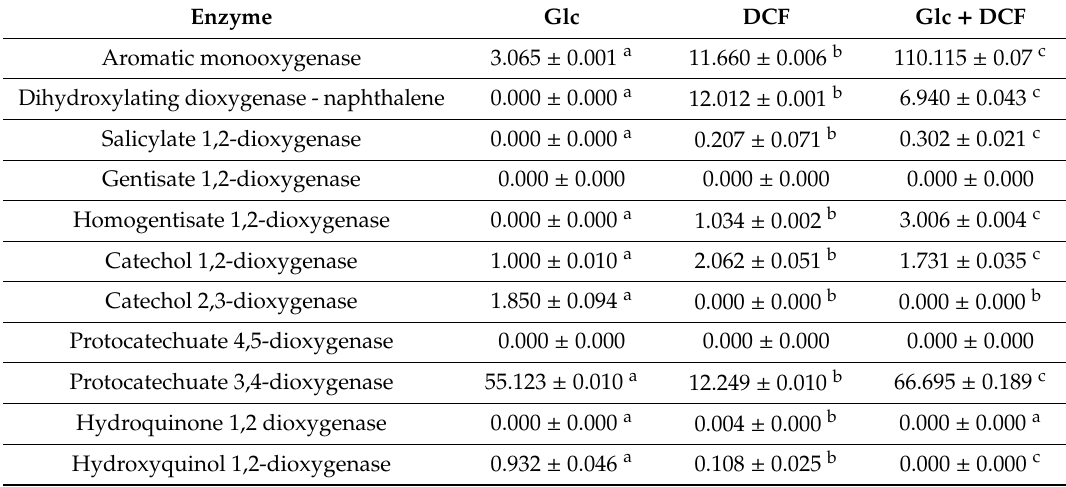
Table 1. The specific activity of selected enzymes (U mg − 1 of protein) measured for control with Glc, mono-substrate conditions with DCF and co-metabolic conditions with Glc and